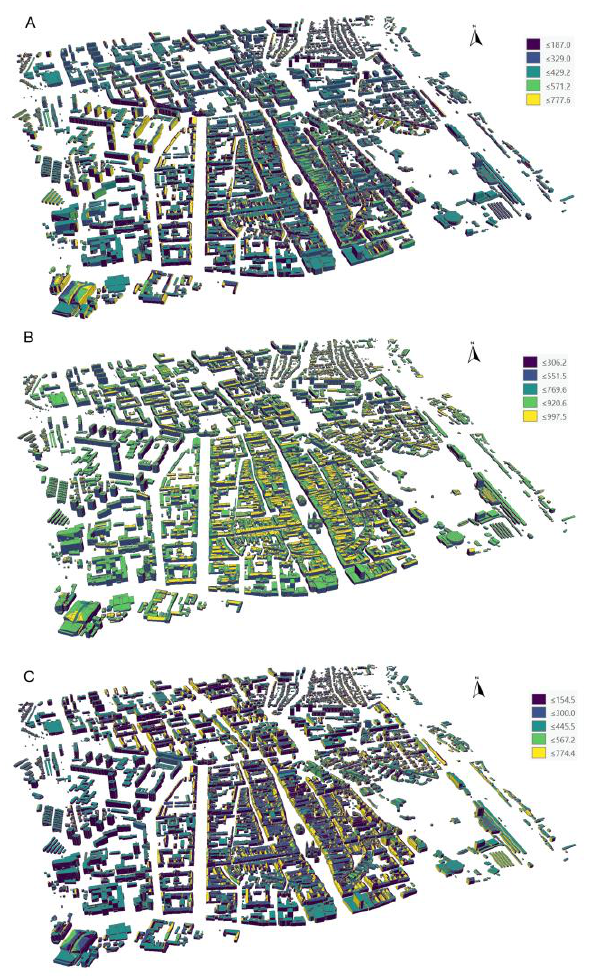
Figure 3 . Solar irradiance (W.m -2 ) calculated by the v.sun module in the city of Košice at A) 7:00, B) 12:00, C) 17:00 on 1 July.